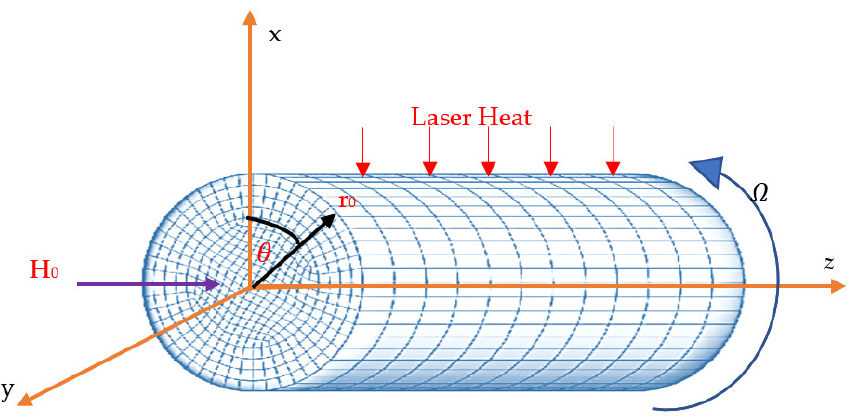
Figure 1. Structure of the problem.